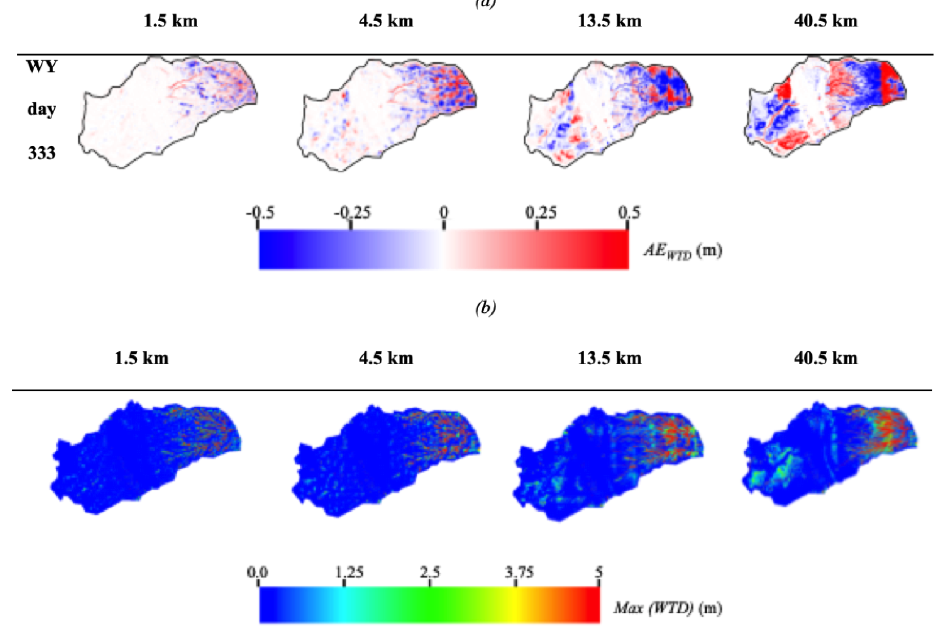
Figure 12. Spatial distributions of (a) the absolute error of water table depth (WTD) (AE WTD ) with respect to the highest spatial resolution of meteorological forcing (0.5km) at WY day 333 and (b) max(AE WTD ) with respect to the highest spatial resolution of meteorological forcing (0.5km).